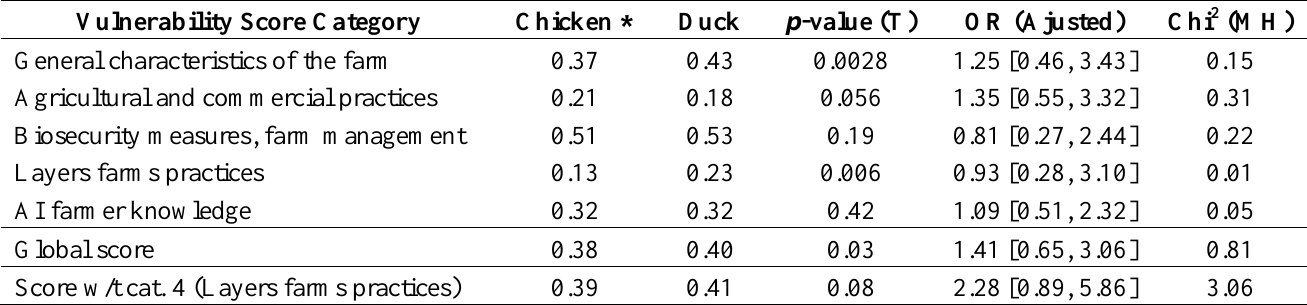
Table 5. Analysis of vulnerability scores by poultry type (chicken or duck), with OR adjusted by production type (meat or layer), and Mantel-Haenszel Chi 2